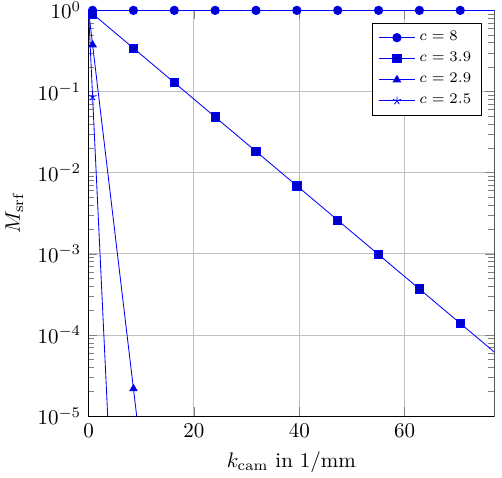
Figure 5. Reflectance surface MTF for different surface gloss pa-